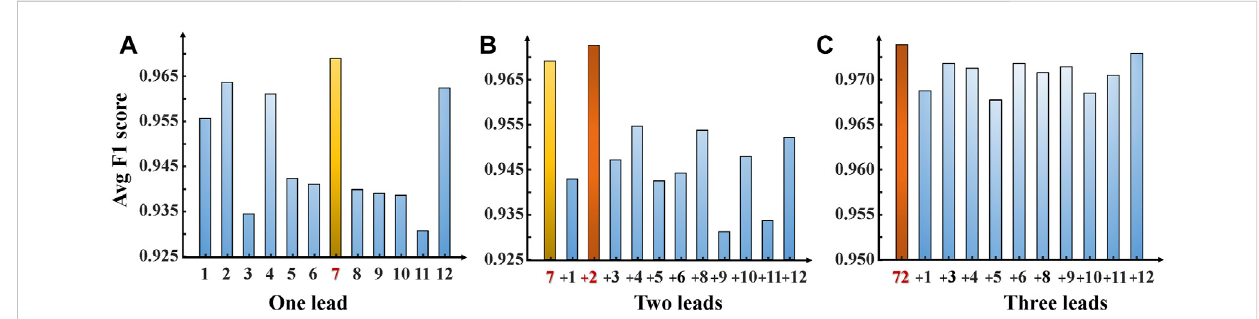
FIGURE 4 F1 scores — ECG leads bar chart. Show the performance F1 score for our ParNet-adv model on each AF prediction experiment. (A) One-lead AF prediction and show the lead V1 achieved the optimal performance. (B) Two-leads AF prediction (addition of each single lead to the lead V1) shows the highest F1 score bar corresponding to the lead V1+ II subset. (C) Three-leads AF prediction (addition of each single-lead to the subset leads V1+II). (1,2,3,4,5,6,7,8,9,10,11,12 stands for lead I, II, III, aVR, aVL, aVF, V1, V2, V3, V4, V5, V6).